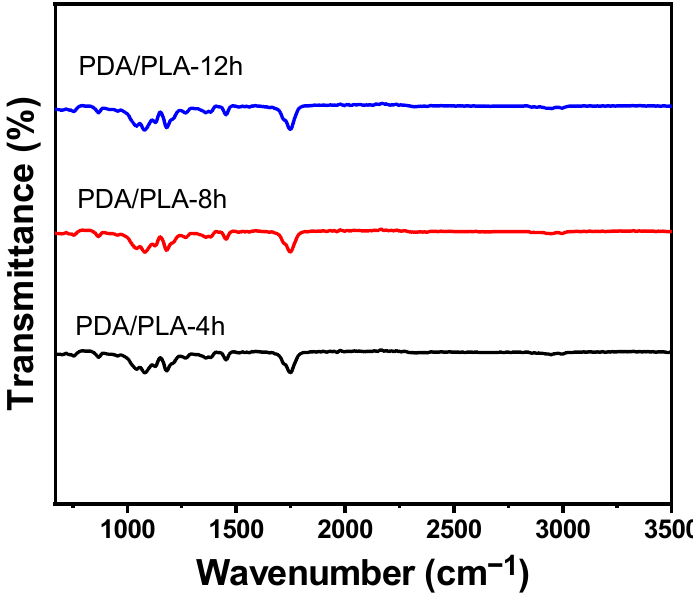
Figure 3. FTIR spectra of PDA/PLA scaffolds with different immersion times in poly(dopamine).